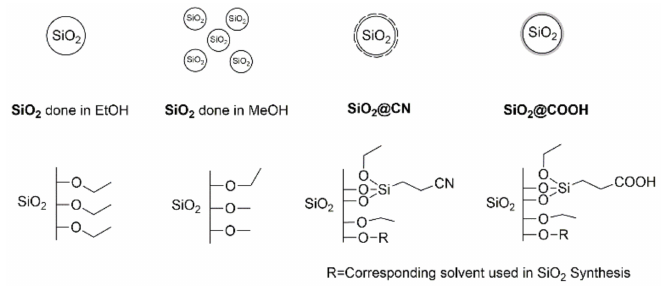
Figure 11. Schematic functions on the silica